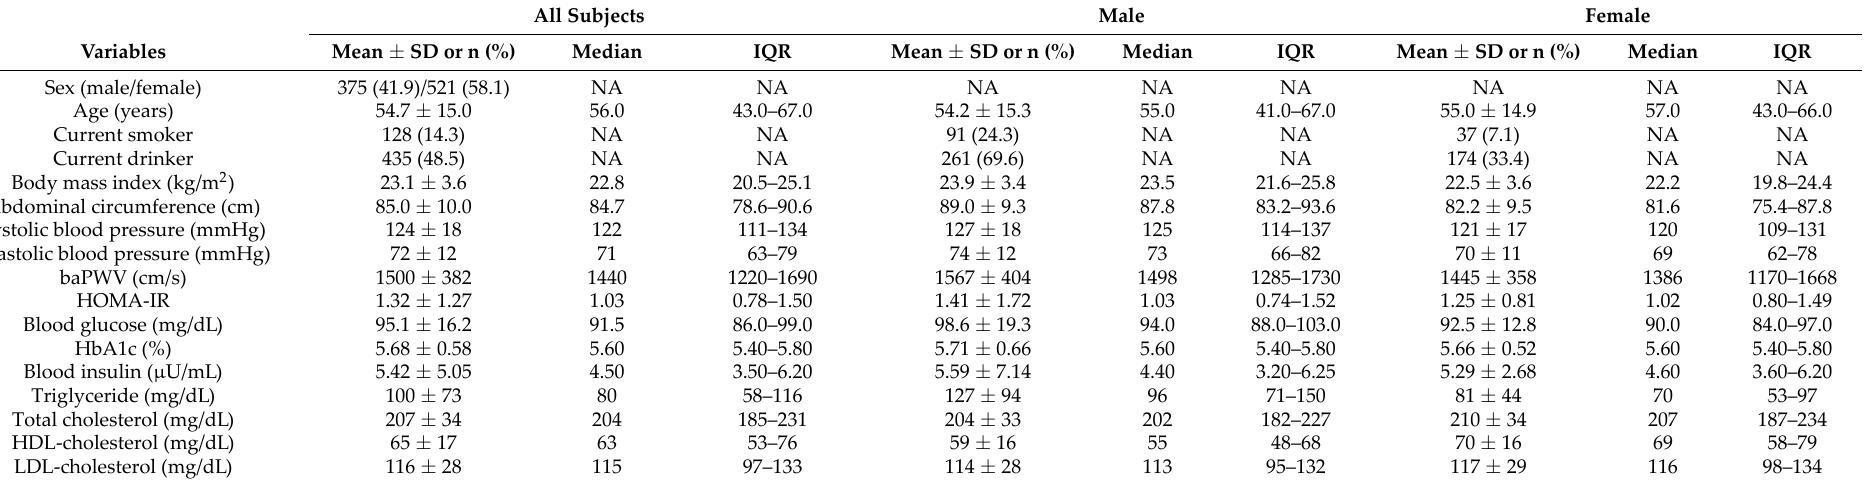
Table 1. Participant characteristics (n =